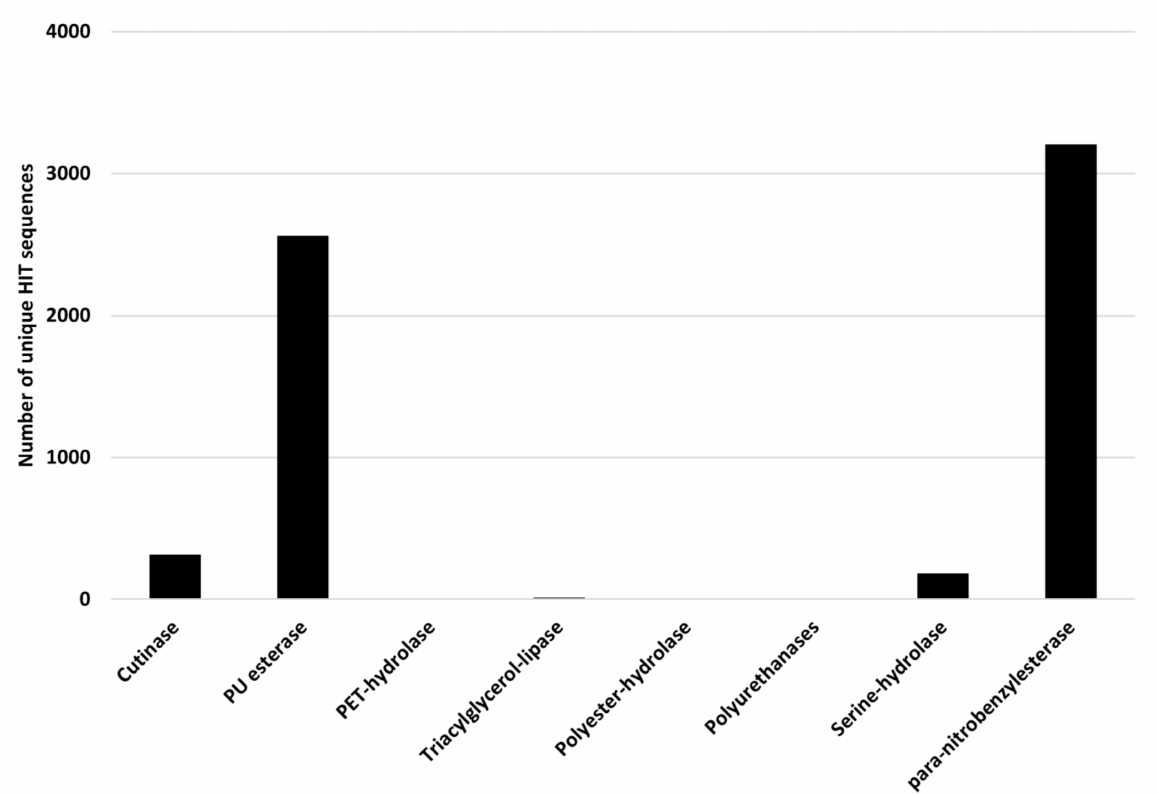
Figure 10. Number of unique HIT sequences identified in Rhodococcus genomes for different enzyme categories putatively related to heteroatomic backbone plastic